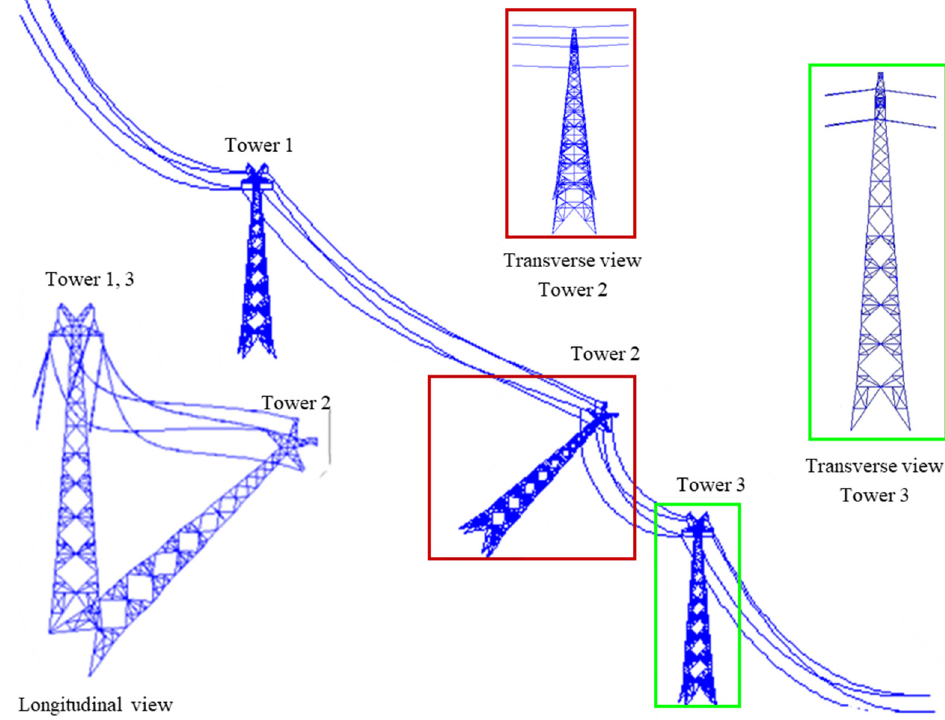
Figure 12. Behavior of the transmission tower-line structure at t = 12 s under Case 1.